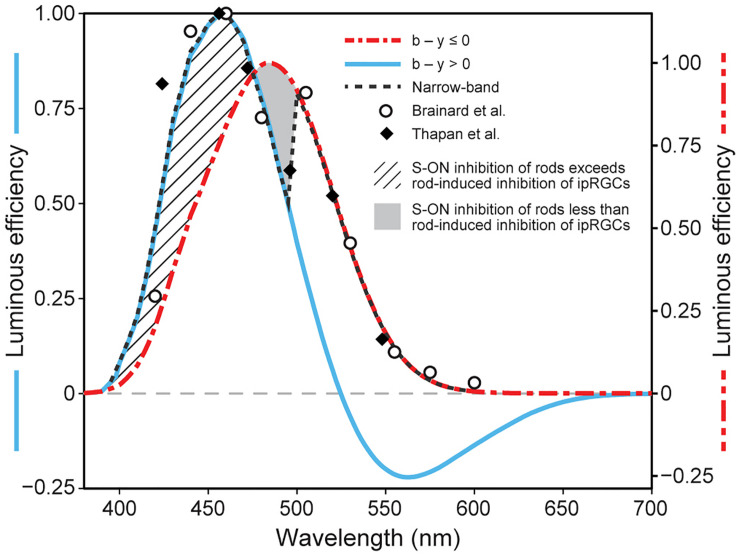
Model predictions of the spectral sensitivity of the circadian phototransduction circuit when exposed to either monochromatic (narrow-band) or polychromatic light sources at 300 scotopic lx at the eye. The spectral sensitivities to monochromatic spectral lights from two studies (closed diamonds Thapan et al., 2001; open circles Brainard et al., 2001) are shown together with the revised model predictions for monochromatic sources (black dashed line) and for polychromatic light sources where the b – y channel signals “blue” (blue solid line) or “yellow” (red dot/dash line). The cross-hatched area represents enhanced spectral sensitivity of the circadian phototransduction circuit to very short wavelengths (< 470 nm) when the SB signals “blue” and can provide added input to the ipRGC. The solid gray area represents the area of reduced spectral sensitivity, relative to that from the ipRGC alone (470–500 nm). This solid gray area of transition to longer wavelengths is due to a systematic loss of S-cone inhibition of rods as the b – y channel comes closer to its spectral cross-point at approximately 500 nm. As the inhibitory SB input to the AII amacrine is reduced (Process A in Figure 1), rod shunting inhibition of the ipRGC increases (Process B in Figure 1). For wavelengths longer than about 500 nm, the SB signals “yellow” OFF, and through the A18 amacrine neuron (Process C in Figure 1) decouples the shunting inhibition of the ipRGC altogether. It should be noted that the light level of 300 scotopic lx was chosen for illustration because rod inhibition is modeled to control threshold for ipRGC activation, thereby providing a common basis for comparing different spectral sensitivity functions and because, empirically, this light level is approximately equal to that producing the half-saturation response levels of nocturnal melatonin suppression. As described in the original model, a progressively smaller “notch” is predicted as light levels increase because cone inhibition of rods becomes relatively larger.